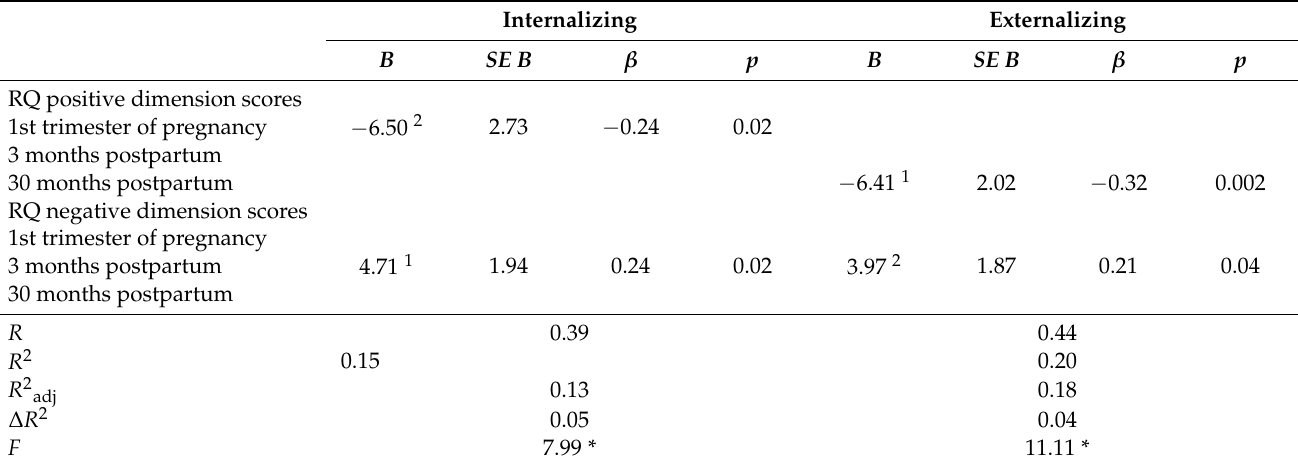
Table 3. Multiple regression analysis for couple’s positive and negative dimensions of the couple’s relationship predicting toddler’s internalizing and externalizing problems. Internalizing Externalizing B SE B β p B SE B β